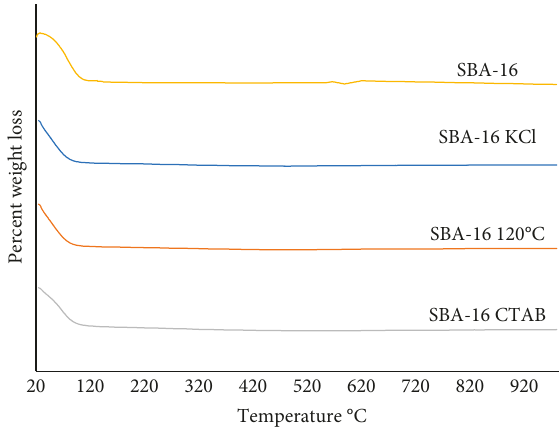
Figure 4: TGA profiles of all prepared